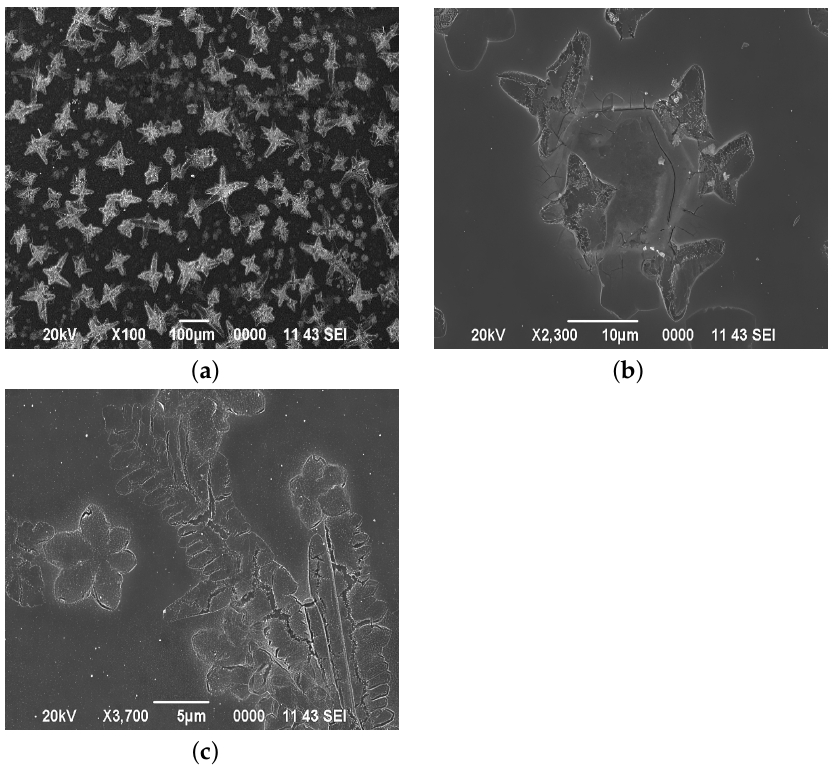
Figure 4. The surface morphology of films obtained from a film-forming system with pH = 1.46: ( a ) × 100 magnification, ( b ) the morphology of large clusters, ( c ) the morphology of the surface between large cluster structures (the area is marked with a red